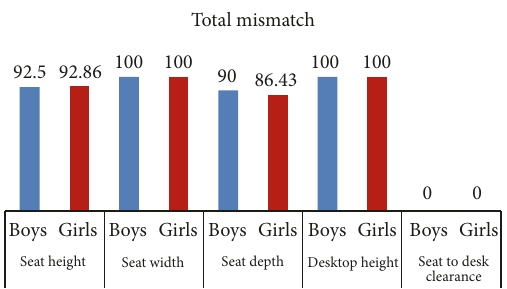
Figure 3: Mismatch percentages for different dimensions by gender.